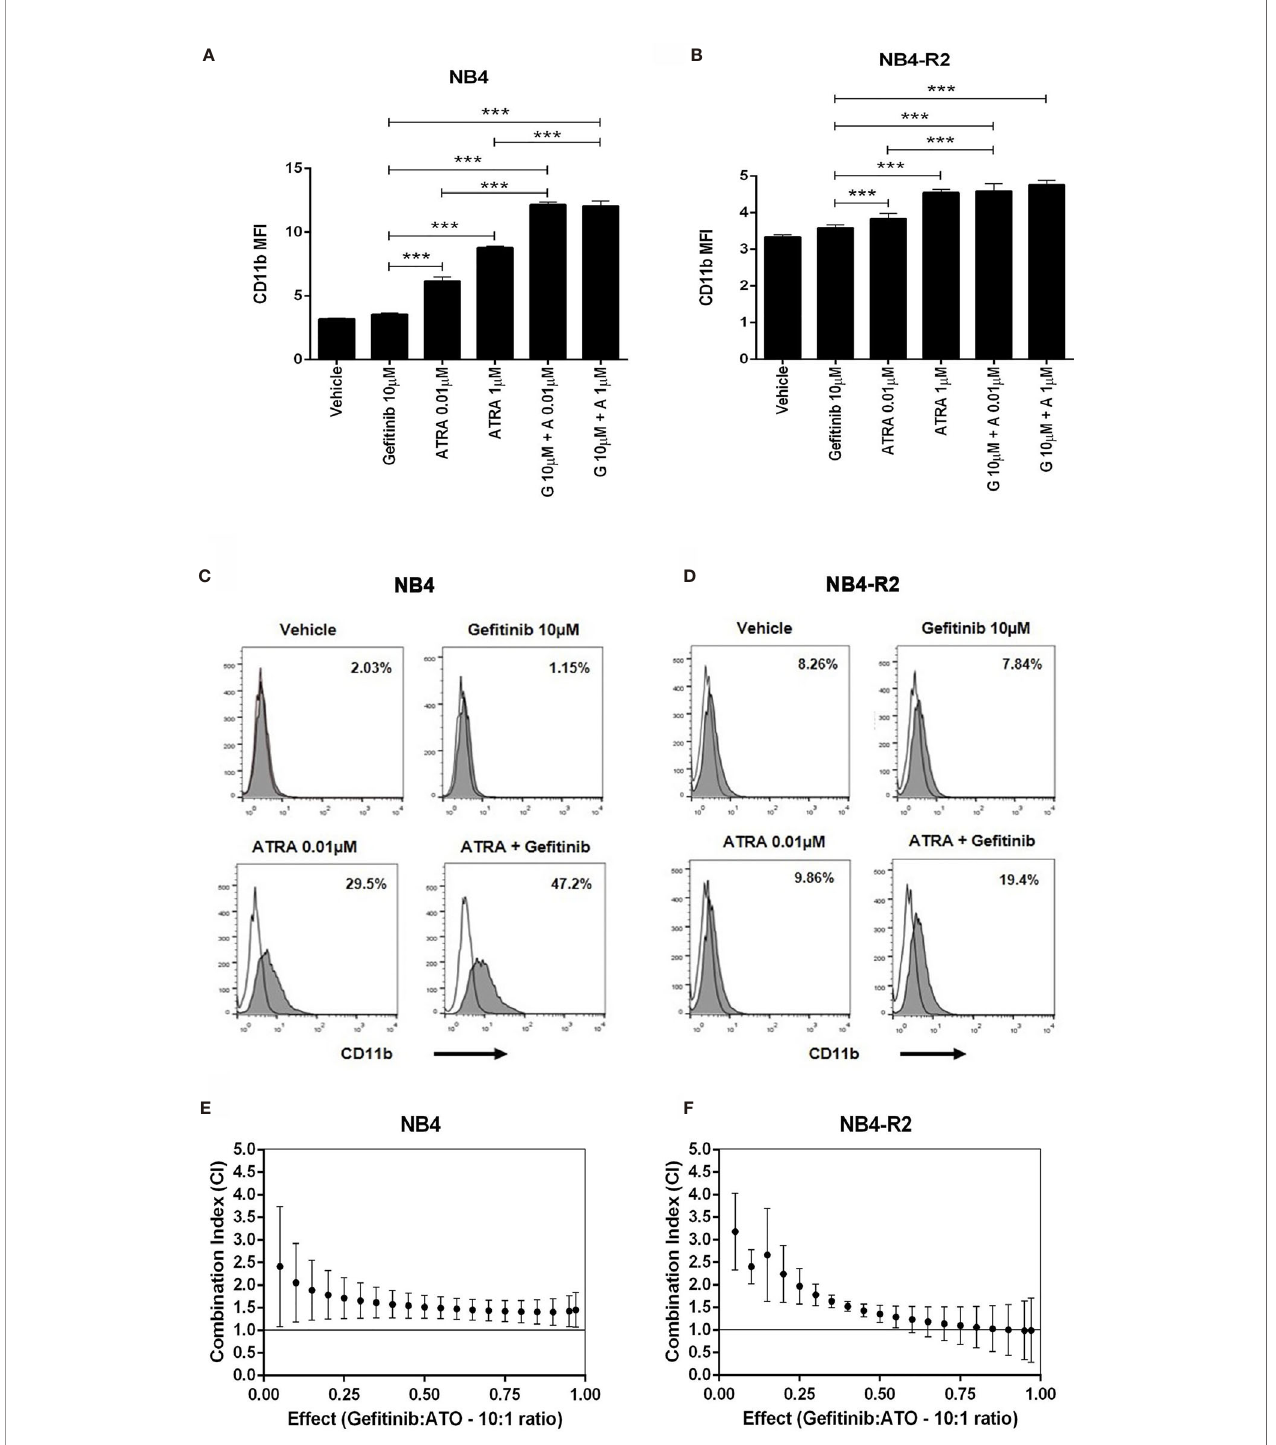
FIGURE 3 | The effect of ge fi tinib combined with ATRA or ATO on NB4 and NB4- R2 cells. (A, B) CD11b MFI of NB4 and NB4-R2 cells treated with ATRA alone (0.01 or 1 m M), ge fi tinib alone (10 m M), or ATRA plus ge fi tinib for 72 h. Ge fi tinib potentiated the myeloid differentiation-inducing effect of ATRA in NB4 (A) and NB4- R2 cells (B) ; representative histograms with percentages for CD11b expression in NB4 (C) and NB4-R2 (D) cells are shown. Plots show the combination index (CI) versus the fractional effect of ge fi tinib plus ATO treatment at 10:1 constant ratio in NB4 (E) and NB4-R2 (F) cells. CI values were calculated by using the CompuSyn software according to the recommendations of Chou and Talalay (21). Data represent the mean ± SD of at least three independent experiments. (***) p < 0.001 (Kruskal – Wallis test, followed by Dunn ’ s post hoc